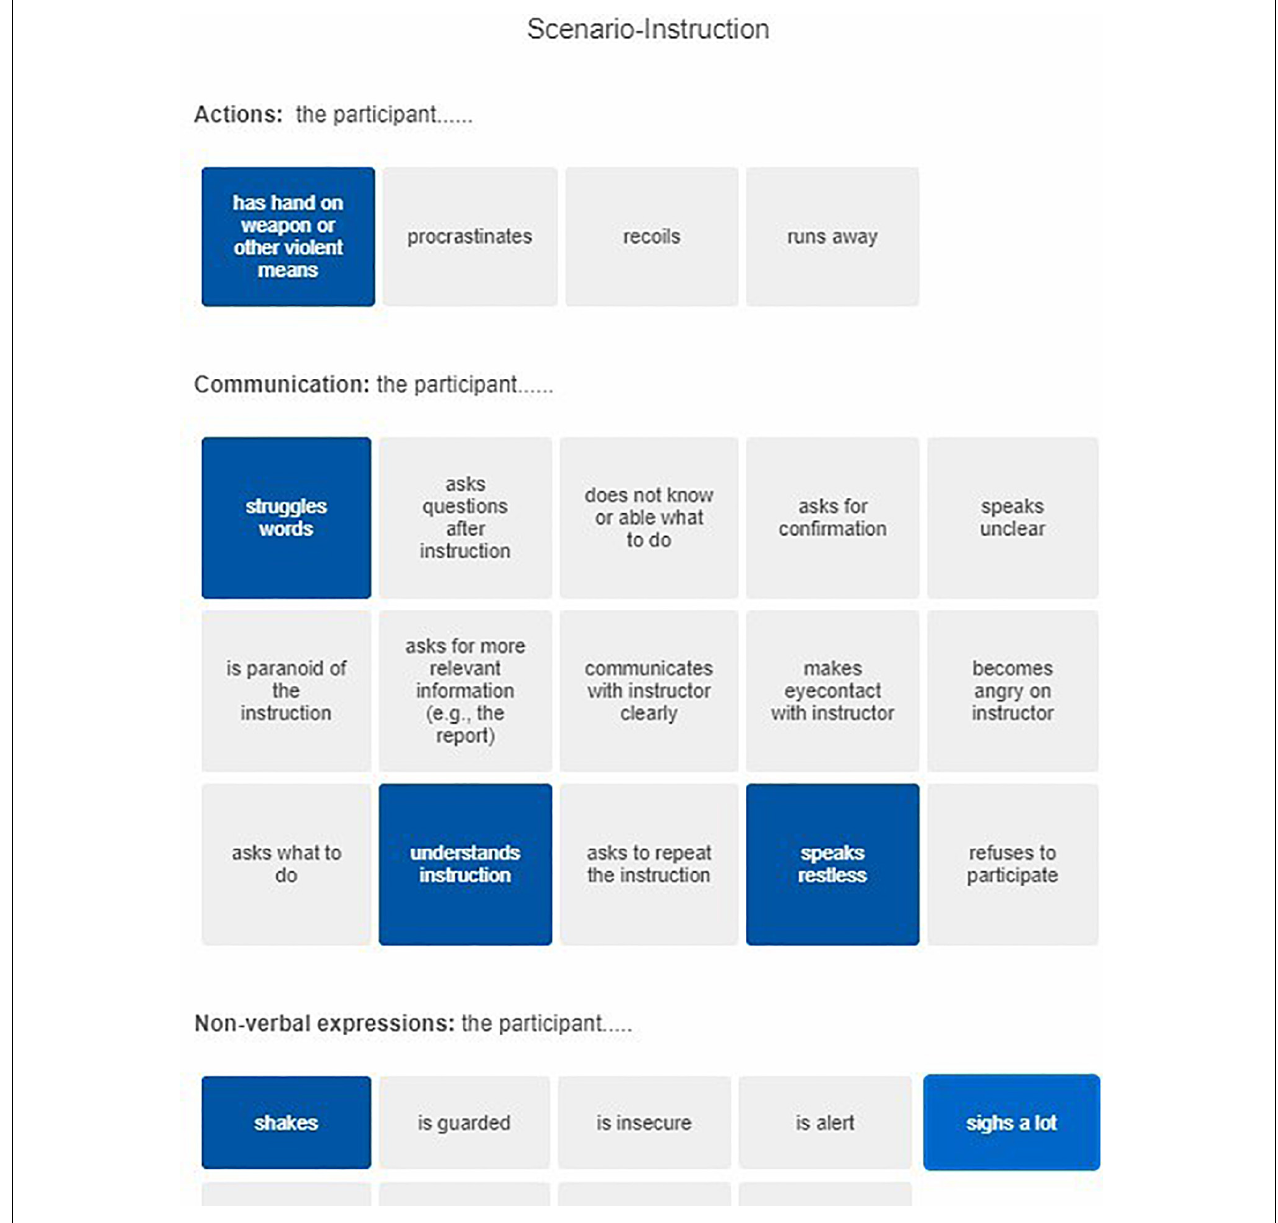
FIGURE 1 | Example page of the assessment instrument used during the behavioral assessment of the experiment. The picture shows how assessors could select/tap behaviors during the